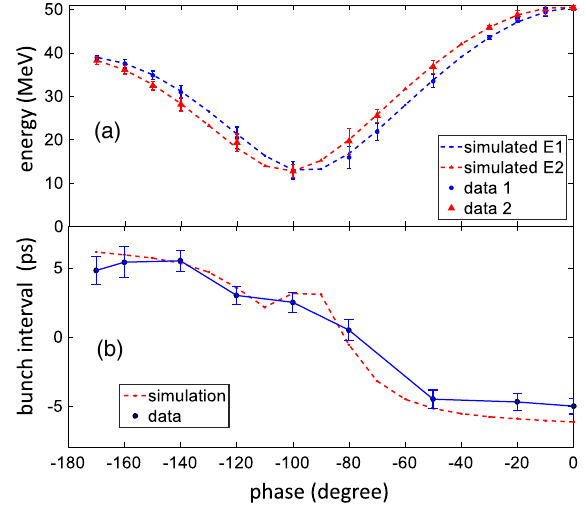
FIG. 8. Comparison between measured data and